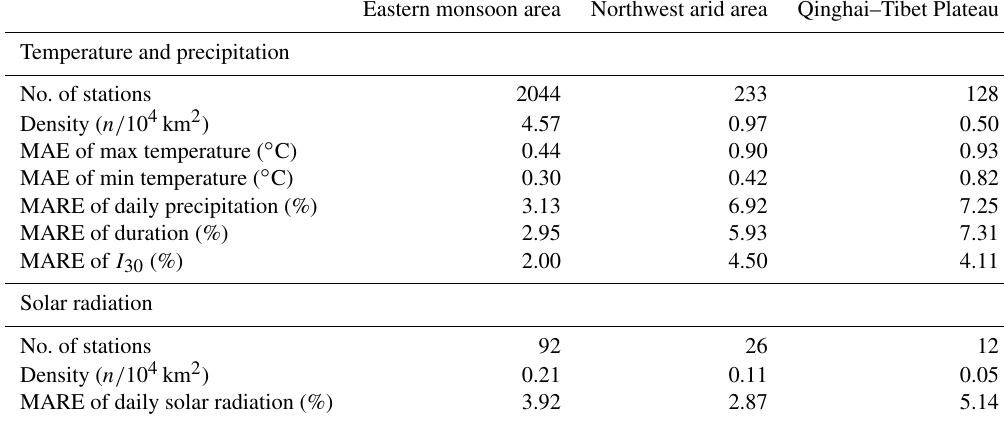
Table 6. Station density and simulation quality of CLIGEN for three Chinese physical-geographical